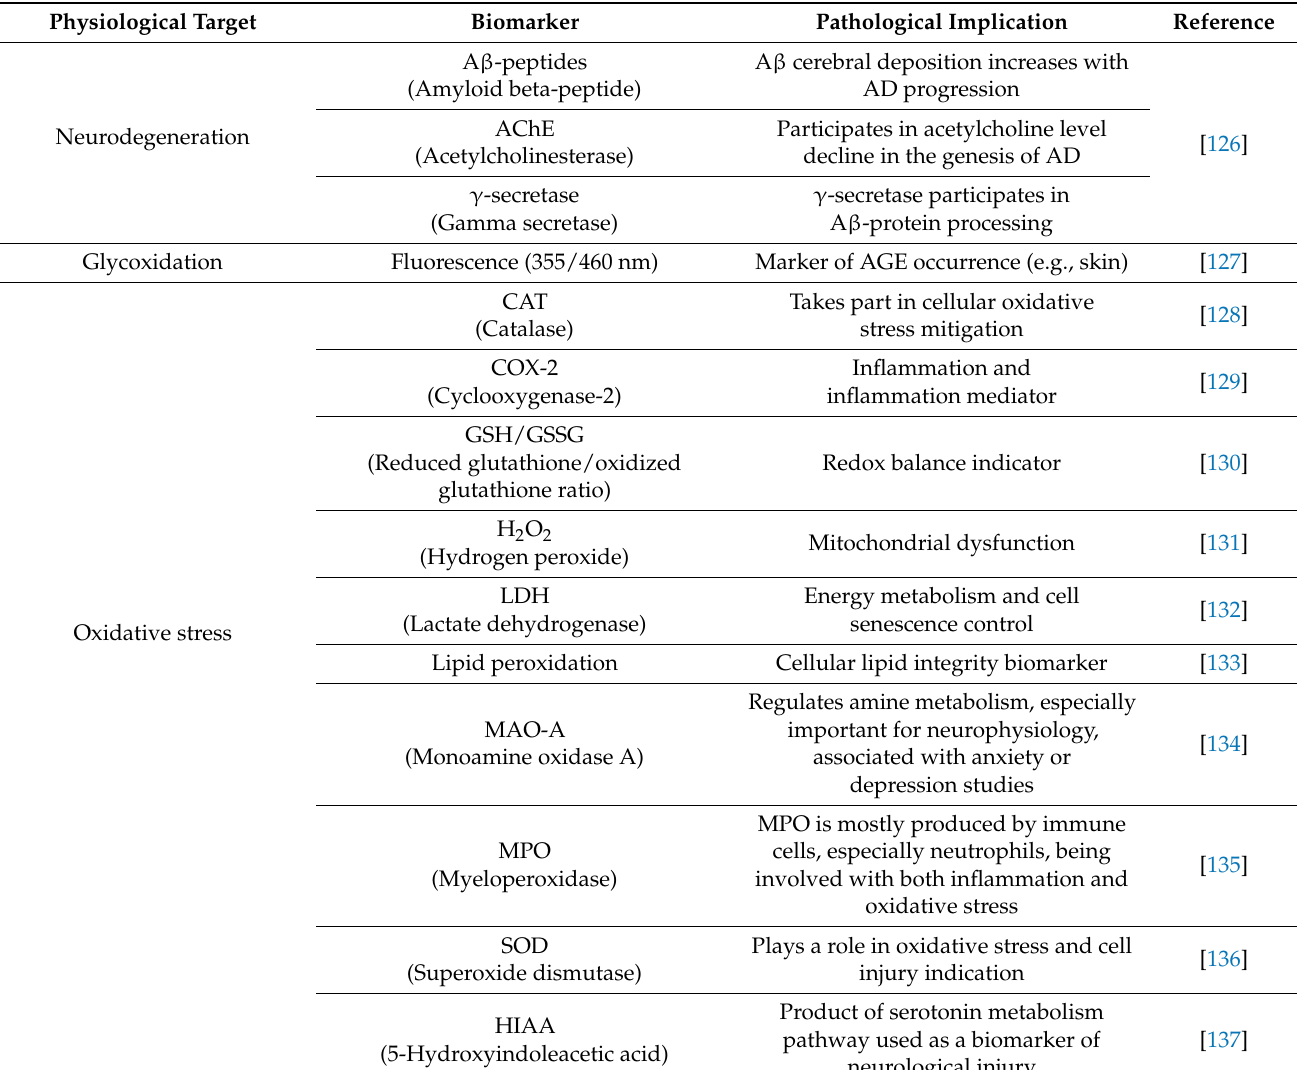
Table 2. Biomarkers related to oxidative stress, glycoxidation, and